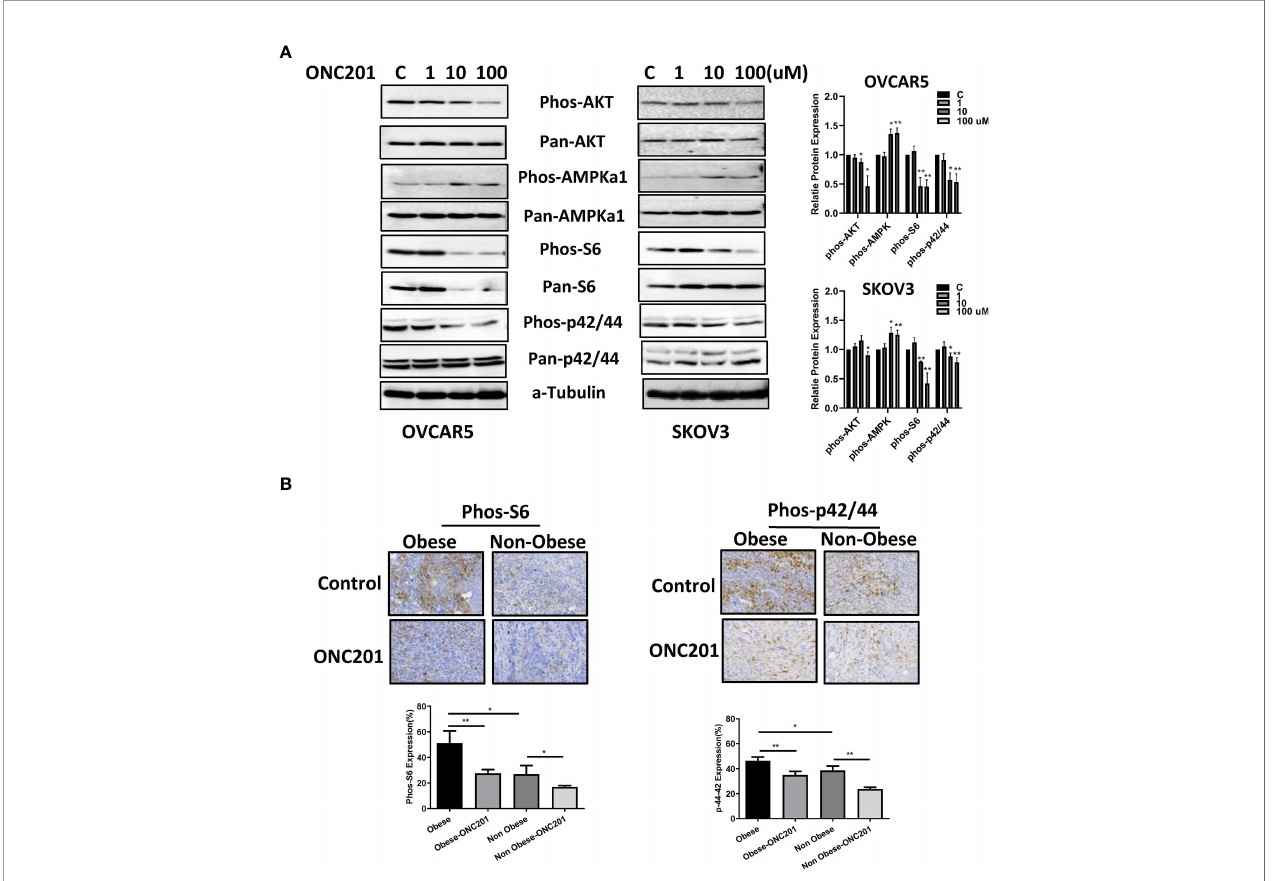
FIGURE 8 | ONC201 activated AMPK and inactivated AKT/mTOR and MAPK pathways. The OVCAR5 and SKOV3 ovarian cell lines were incubated with ONC201 at various concentrations for 24 hours. Western blotting results indicated ONC201 decreased the expression of phosphorylated Akt, S6, p42/44, and increased the phosphorylated AMPK expression in both cell lines (A) . The KpB mice were treated with ONC201 for 4 weeks. IHC results showed that obesity increased expression of phosphorylation of S6 and p42/44, and ONC201 signi fi cantly decreased the expression of phosphorylated p-S6 and p42/44 in ovarian tumors under obese and lean conditions (B) . * <0.05, **